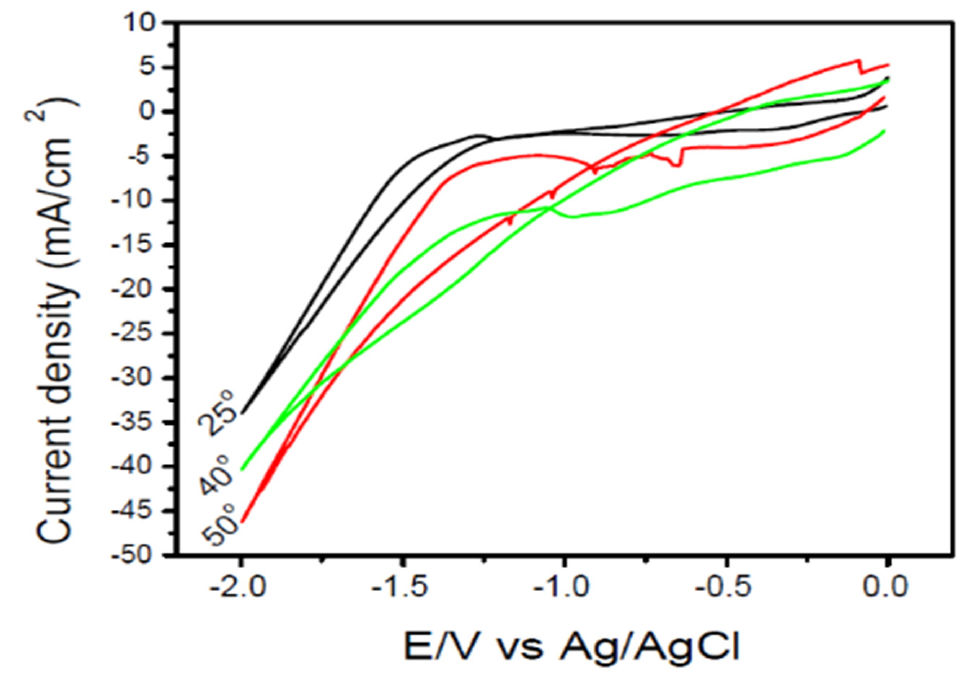
Figure 8. The cyclic voltammograms on pure Cu. Figure 9 represents the cyclic voltammogram (CV) of the four fabricated Cu-MWCNT nanocomposites with 0, 0.4, 0.8, and 1.2 wt.% MWCNTs. Curves A and B show an iden- tical behavior of pure Cu and the 0.4 wt.% MWCNTs with a cathodic current density of − 47 mA · cm − 2 . We observed that the 0.4 wt.% MWCNTs had no effect on the recorded voltammogram curve. This may be due to the negligible effect of the 0.4 wt.% MWCNTs on the cathodic current density of the sample. For the 0.8 wt.% MWCNTs, the cathodic current density increased and promoted ZnO film deposition.